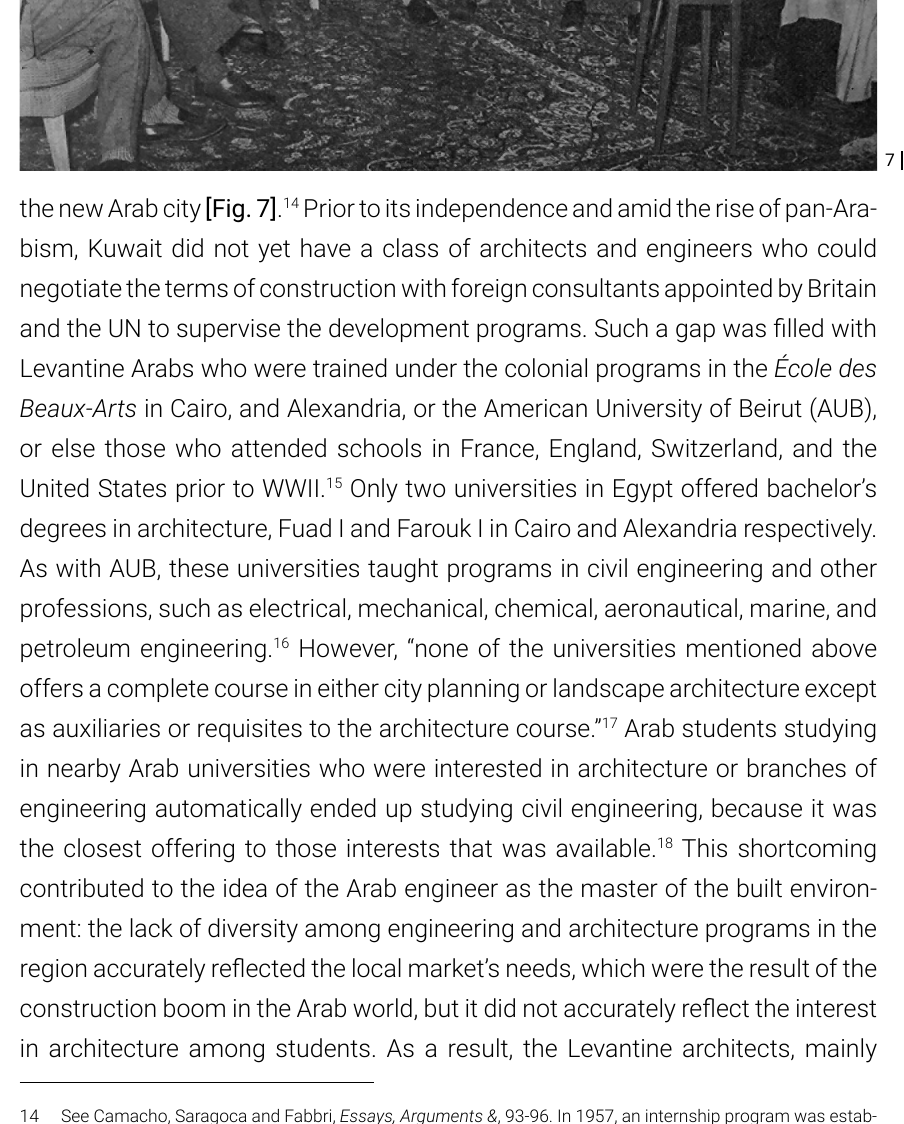
Fig. 7 Picture from the Kuwait Engi- neering Society in the 1960s where young Kuwaiti engineers are attending a discussion session organized by Levantine Arab Engineers. Source: Shiber Archive, Washington, DC. ©